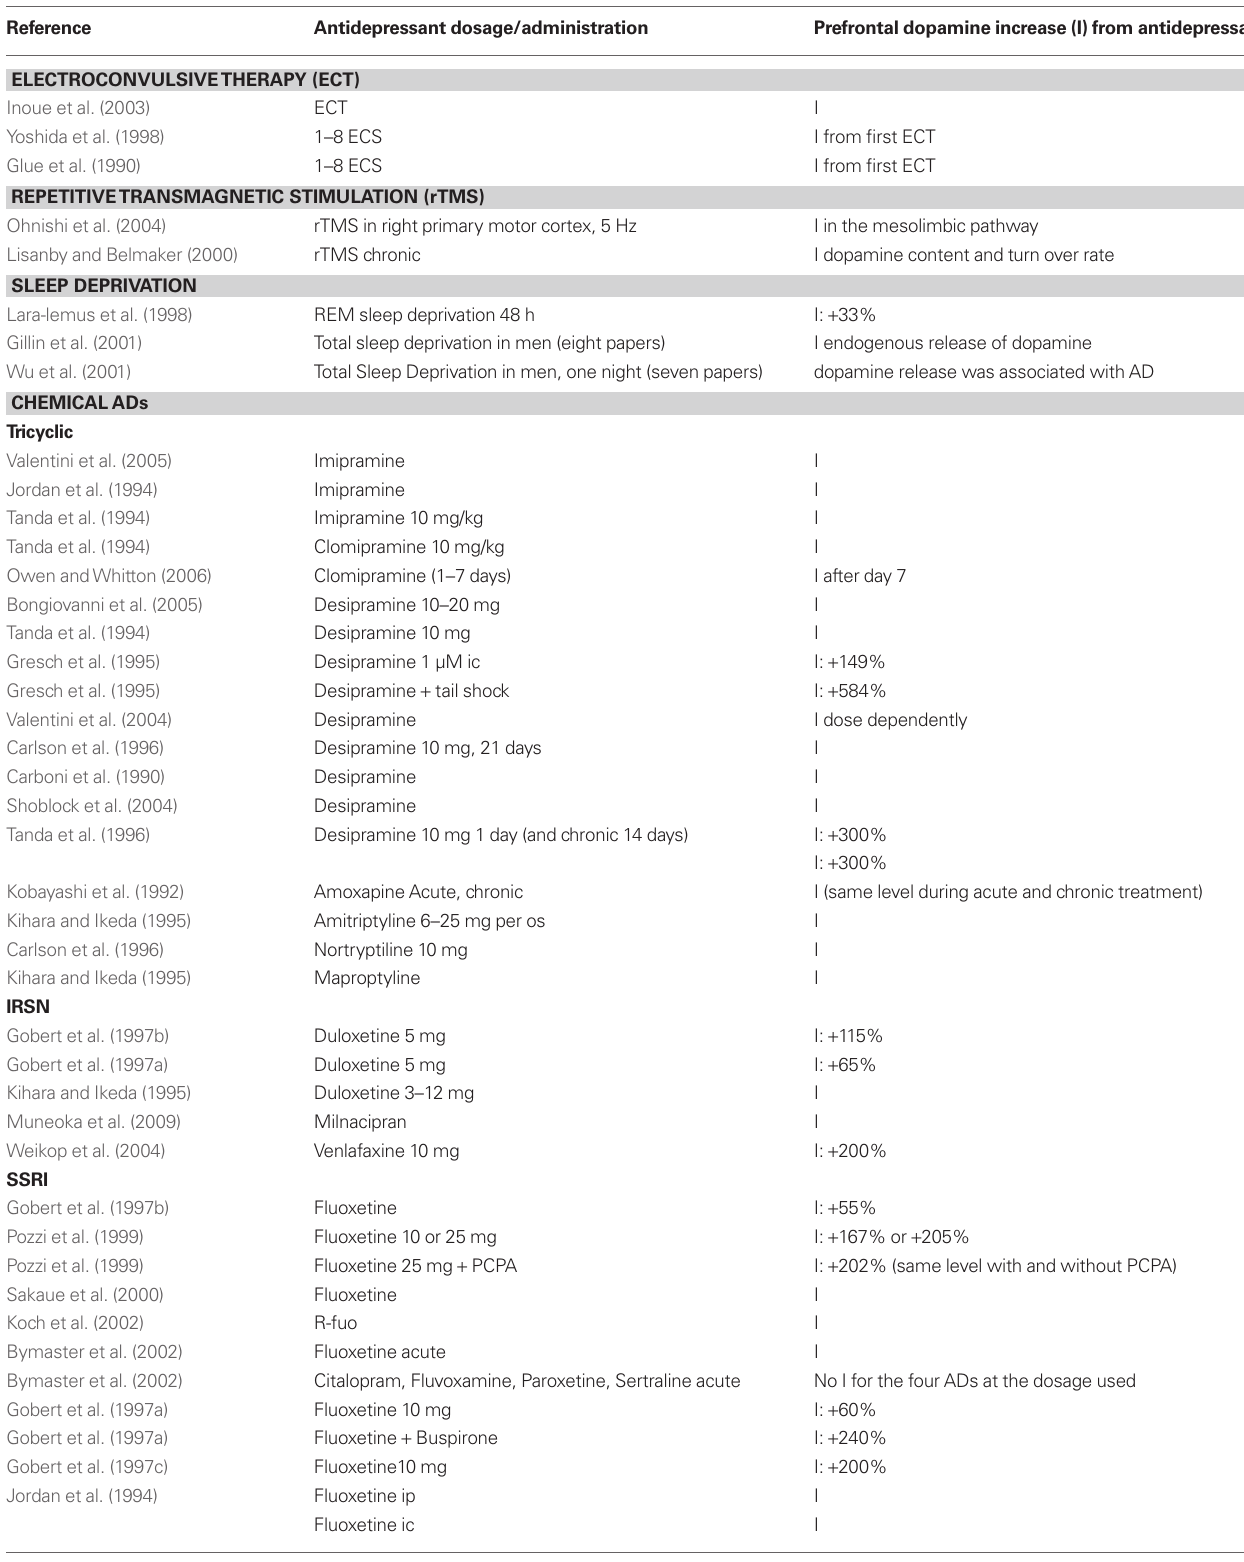
Table 1 | Prefrontal dopamine release from antidepressant